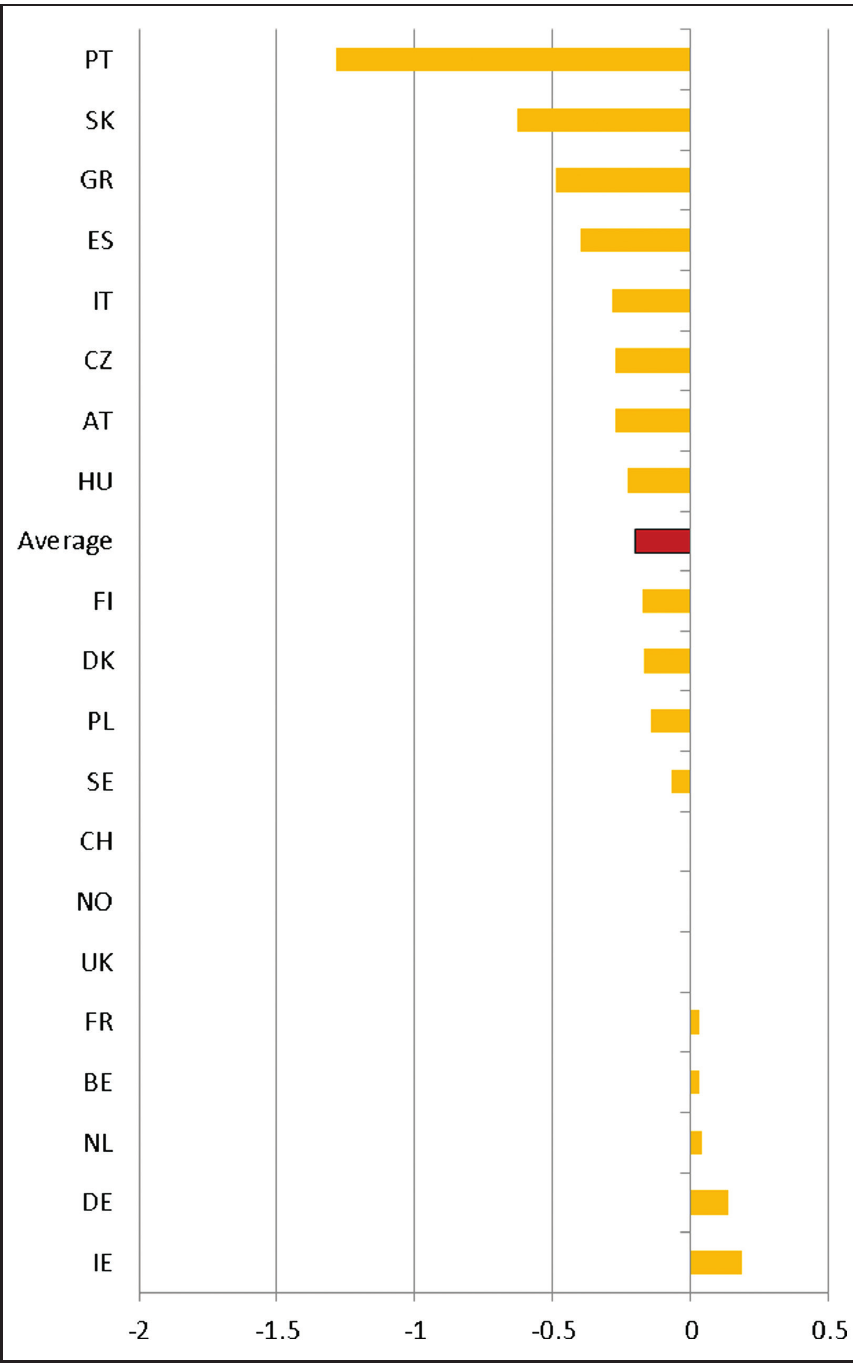
Labor market reforms between 1998 and 2013 (change in the EPL OECD index). Note: Estonia, Luxembourg, Slovenia, and Iceland are not presented in the graph since data on their EPL are available only over the period